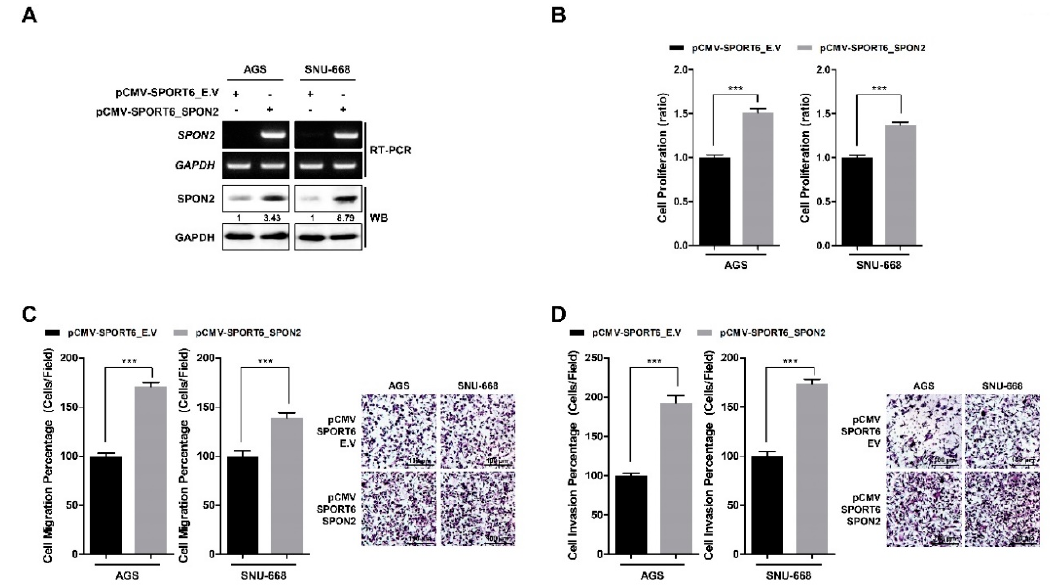
Figure 3. SPON2 overexpression promotes cell proliferation, migration, and invasion in gastric cancer cells. ( A ) Overexpression of SPON2 in AGS and SNU-668 cells was achieved by transfection with an empty vector (pCMV-SPORT6_E.V) or SPON2 -overexpressing vector (pCMV-SPORT6_SPON2). SPON2 expression levels were detected by RT-PCR and Western blot analysis. ( B ) Cell proliferation was detected by WST-1 assay. ( C ) Cell migration and ( D ) invasion abilities on scRNA or SPON2 siRNA transfection were detected by trans-well cell migration and invasion assays, which are presented in the form of graphs (left) and images (right). Data are presented as mean ± SEM ( n = 5). p -values were calculated using Student’s t -test, and significant differences are indicated by * (*** p < 0.001).